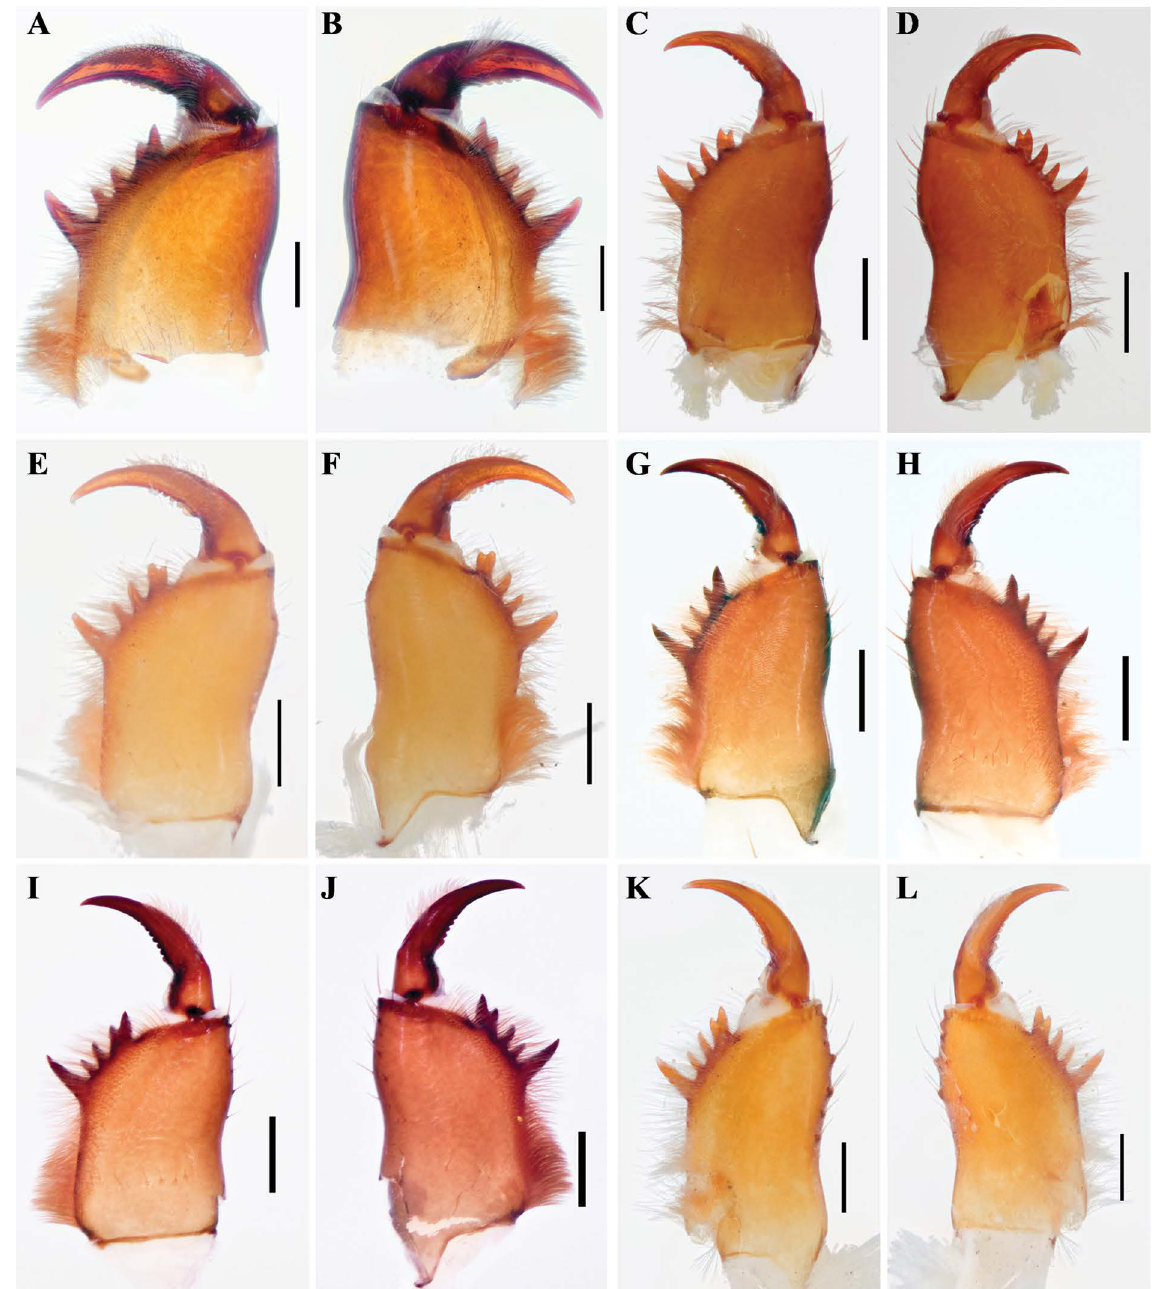
Fig. 10. Charinus Simon, 1892, chelicerae, prolateral and retrolateral views. A–B . Charinus loko sp. nov. (SMNS). C–D . Charinus miskito sp. nov. (SMNS). E–F . Charinus mocoa sp.